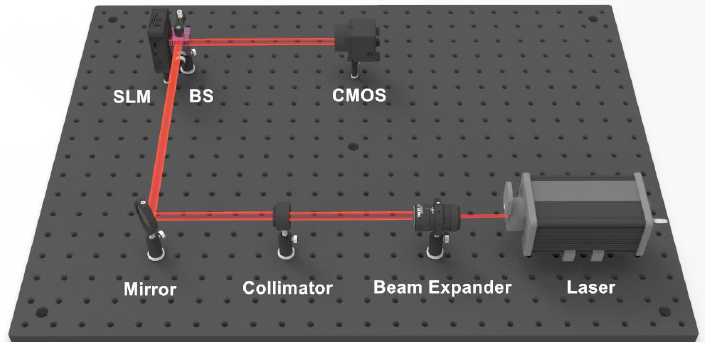
Figure 10. Schematic of optical experimental set-up.